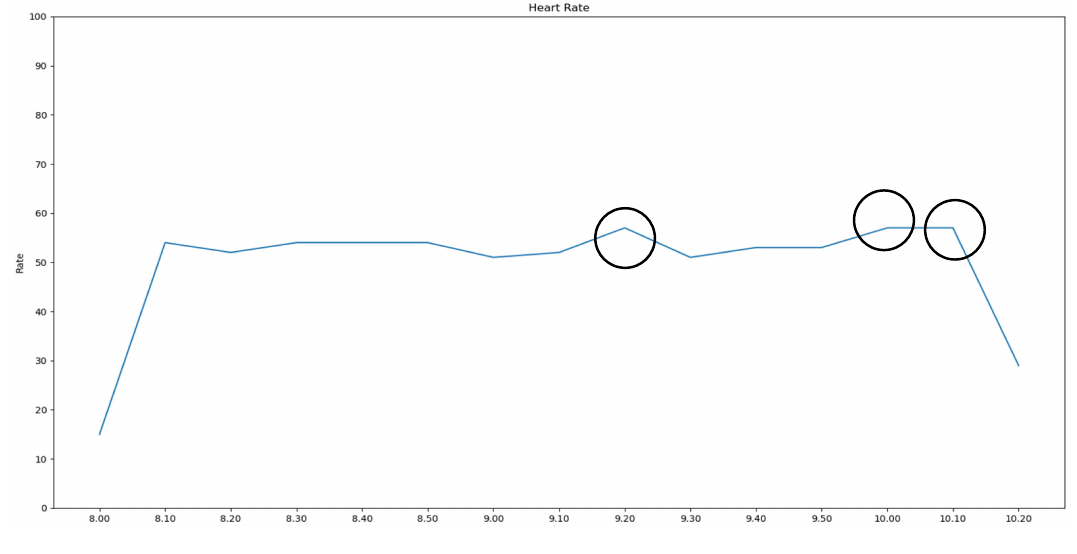
Fig. 2 Student #1 heart rate measurement during Class A at 8.00